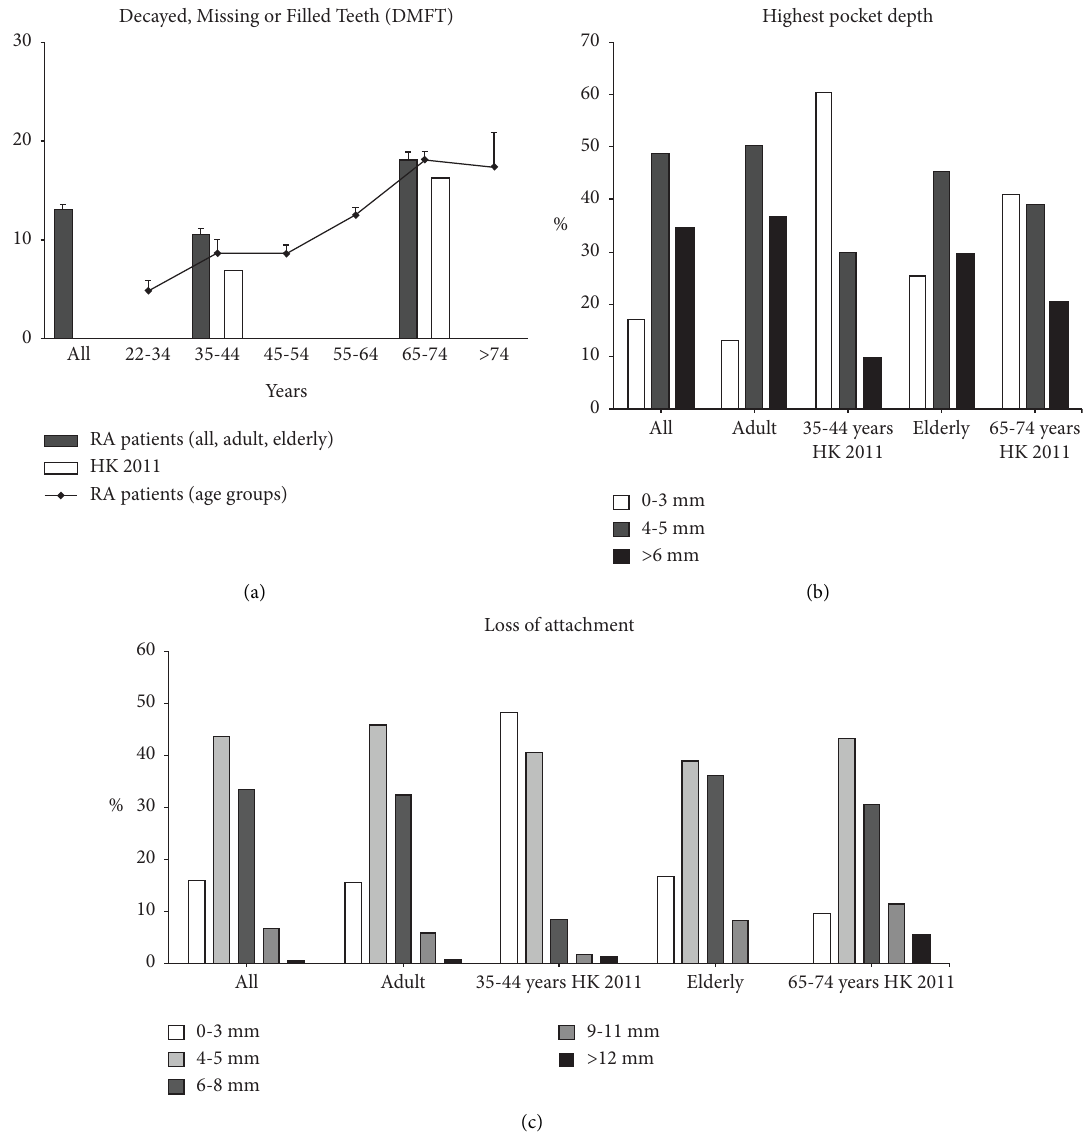
Figure 2: Dental and periodontal outcomes of rheumatoid arthritis patients. (a) DMFT score of RA patients by 10-year age groups (line representation) and by adult and elderly categories in comparison with age-matched community subjects in the 2011 Oral Health Survey (bar representation). (b) Percentage of RA patients with diferent extent of the highest pocket depth and (c) loss of attachment by adult and elderly